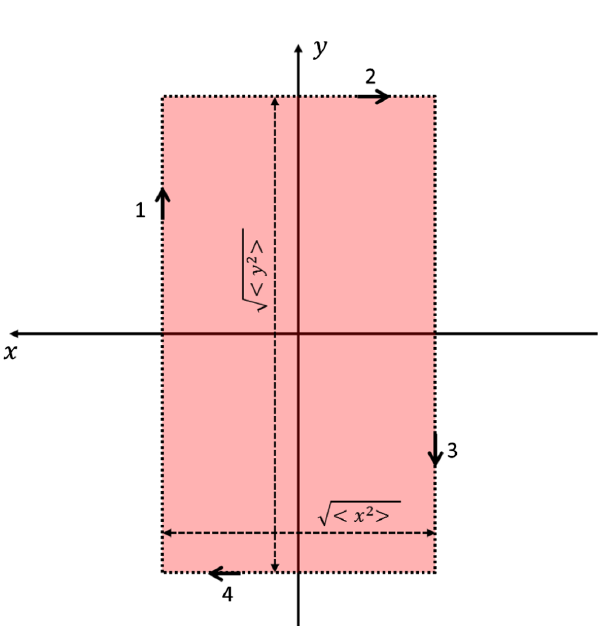
FIG. 1. Definition of the beam rms-area for the case of h xy i ¼ 0 this